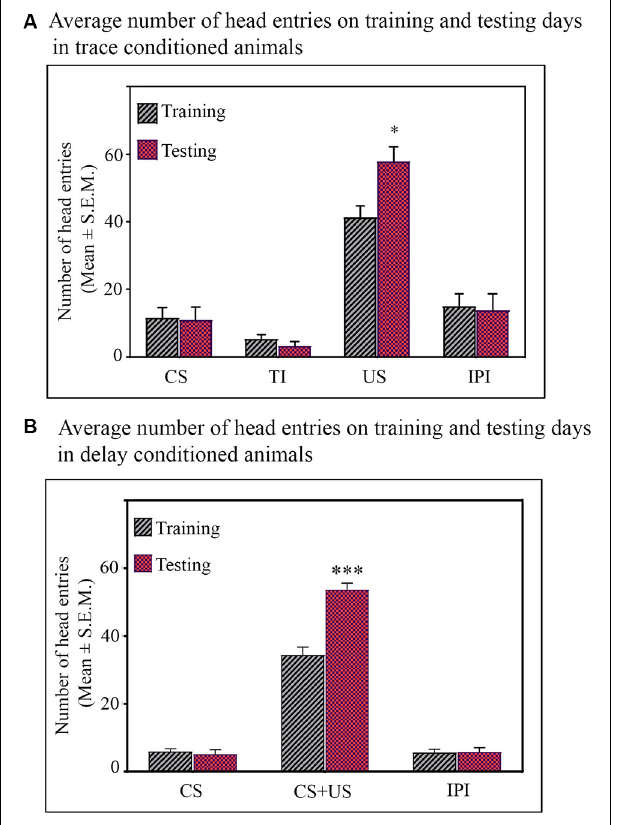
FIGURE 2 | Average number of head entries on the training and testing days in the (A) trace-conditioned animals ( n = 7). Animals showed significantly more number of head entries during the US presentation on testing day ( ∗ p < 0.05; F (1,13) = 6.73, one-way analysis of variance (ANOVA) followed